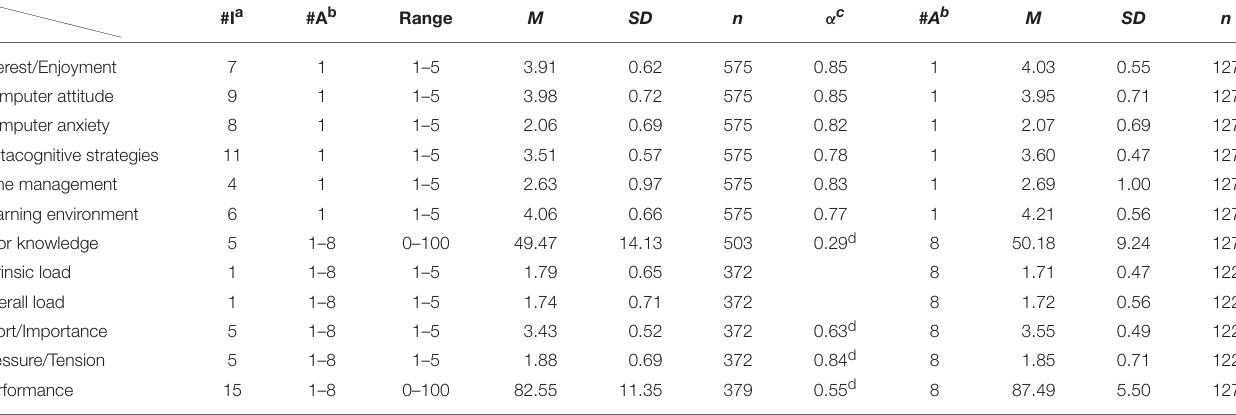
TABLE 1 | Descriptive statistics of